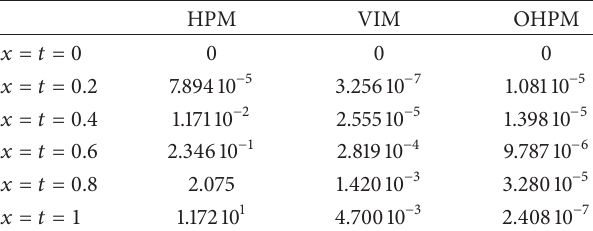
Table 1: The absolute differences corresponding to the HPM solution (red surface), VIM solution (blue surface), and OHPM solution (green surface) for problem